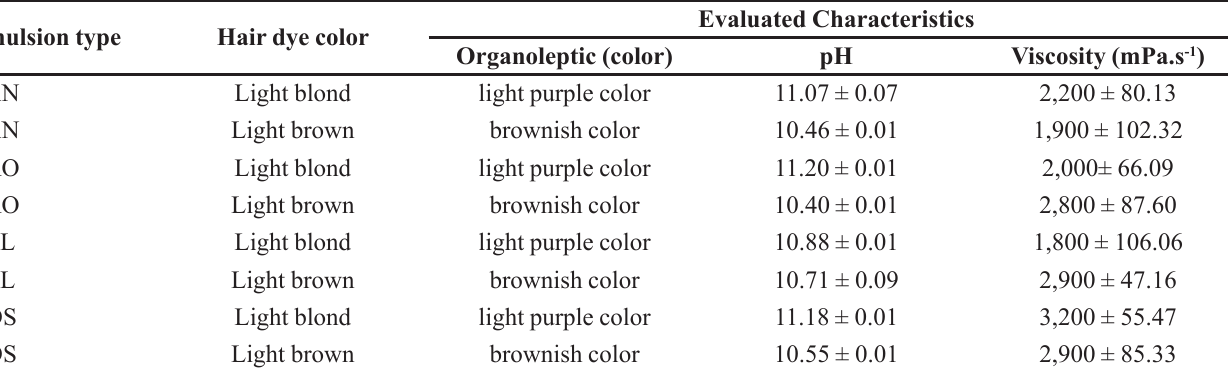
TABLE I - Physic-chemical and organoleptic characteristics of different hair dye color emulsions types Emulsion